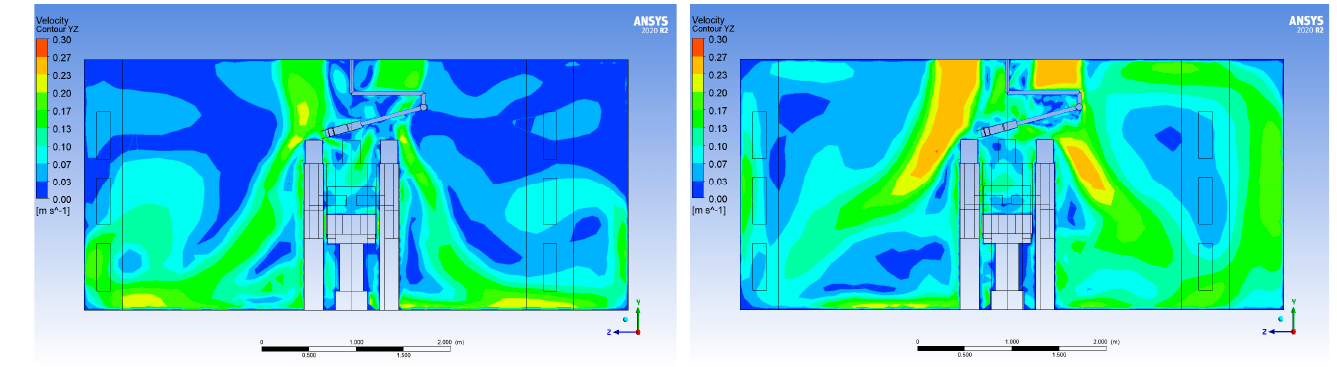
Figure 6. Air velocity pro fi les for outlet air velocity of 0.15 m/s ( left ) and 0.25 m/s ( right ) over LAFC [19].